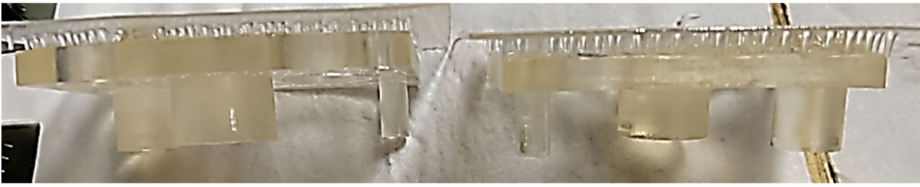
Figure 5. The clear parts printed with 10 s for heavy structure in the left position and 8 s for medium structure in the right